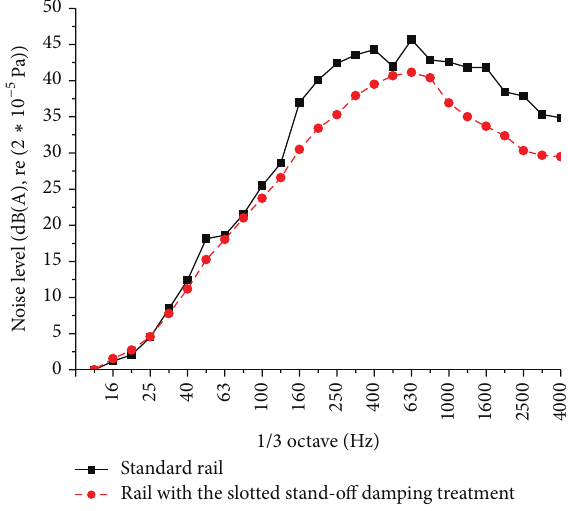
Figure 19: One-third octave curve in lateral excitation.